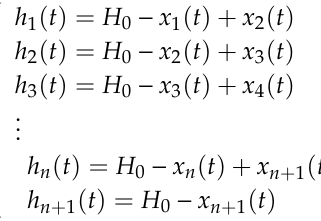
Figure 5. Variation of oil film thickness between N pairs of friction pairs and pressure plates When the spring preload force pushes the first dual steel piece to generate a slight displacement, the thickness H 0 of the first oil film will become thinner, and the bearing capacity of the oil film will increase, thereby pushing the latter friction pair to move, reducing the thickness of the second oil film H 0 . The dynamic oil film thickness equation between the N pairs of friction pairs and the pressure plate is established as follows: